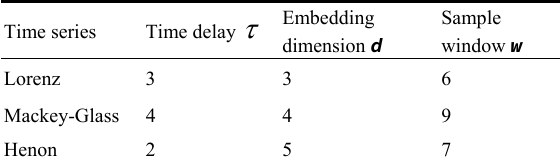
Table 1. The phase space reconstruction